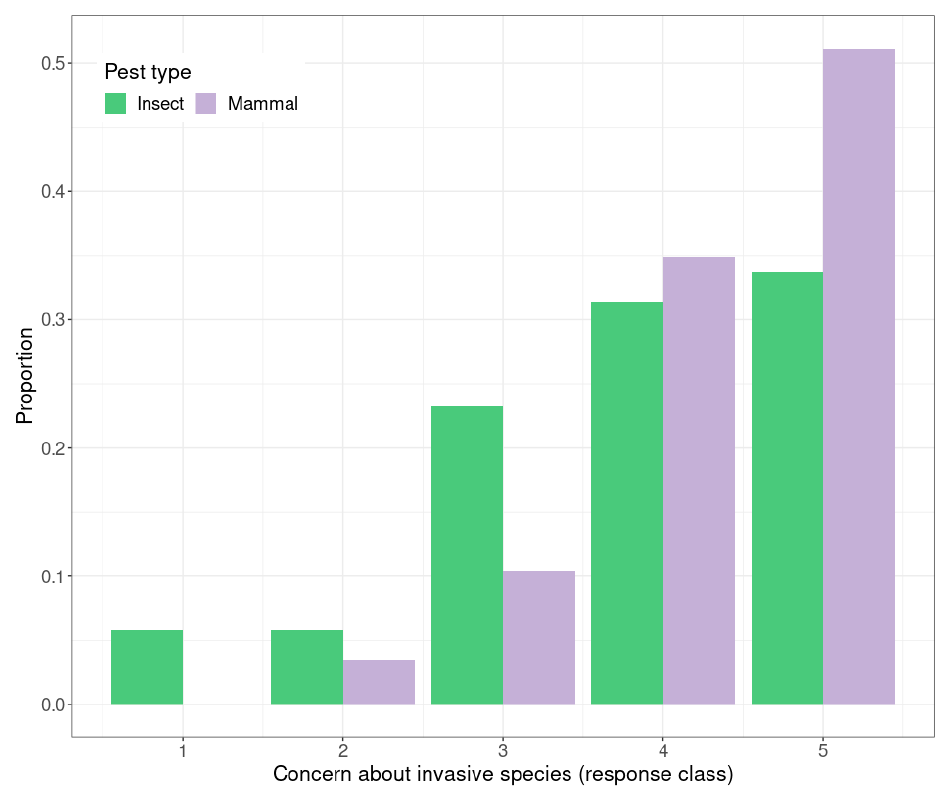
Figure 3. The proportion of respondents with different levels of concern about invasive mammalian pests compared with concern of invasive insect pests. The scale ranges from 1 to 5 (1 being not very concerned, 5 being very concerned) ( n = 86).